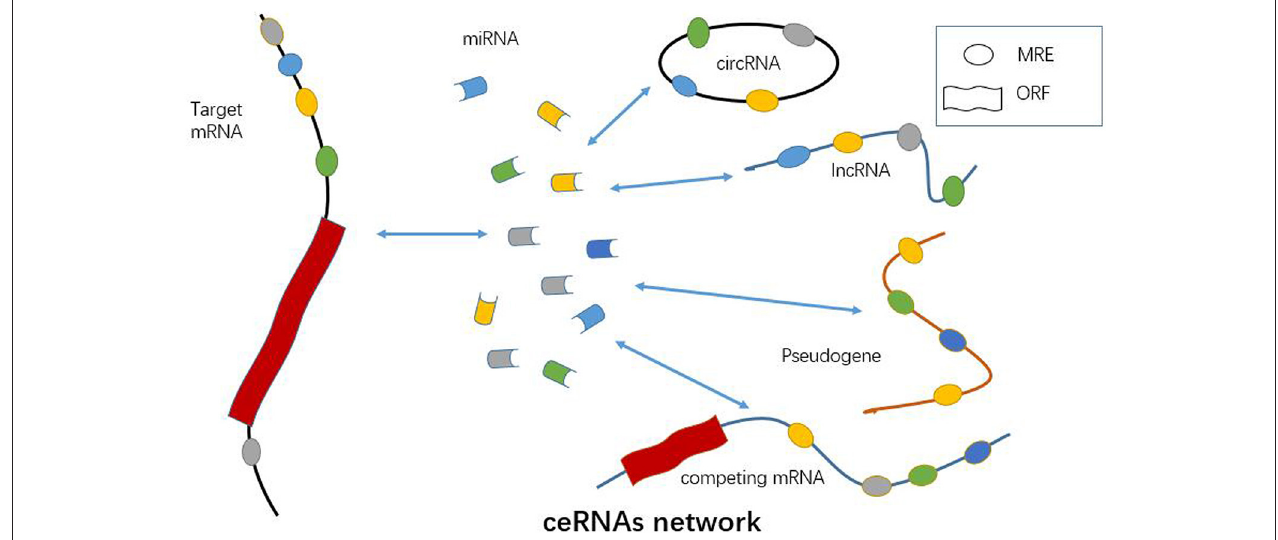
FIGURE 2 | Functional role of ncRNAs as ceRNA. A number of miRNAs, lncRNAs, circRNAs, pseudogenes, and competing mRNAs can act as ceRNA and promote the expression of targeted mRNAs via sponging miRNAs. CeRNA network is a crucial mechanism of ncRNAs involved in RA pathogenesis. cytokines, NF- κ B, and IRF3/IRF7 that are most likely involved